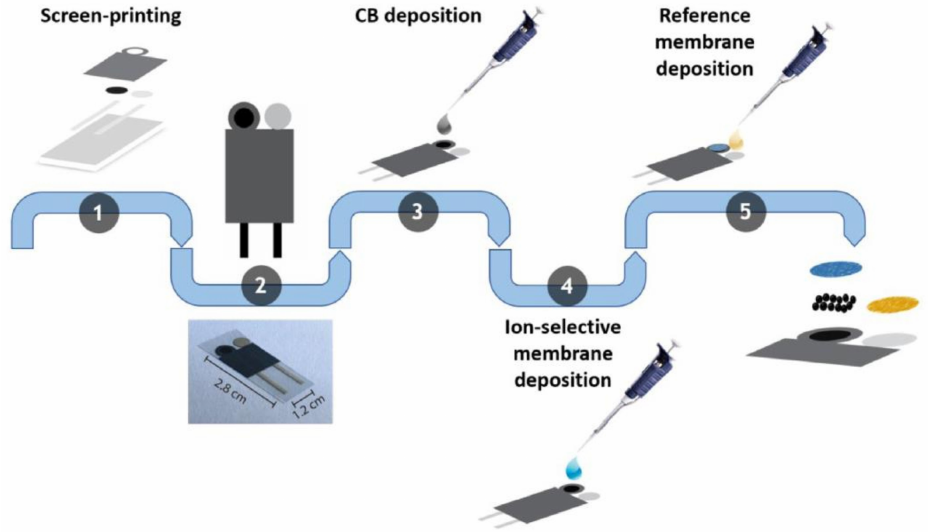
Figure 35. Diagram illustrating the many stages associated with producing modified SPEs. (Repro- duced from [578] with permission. Copyright 2021, Elsevier, Amsterdam, The